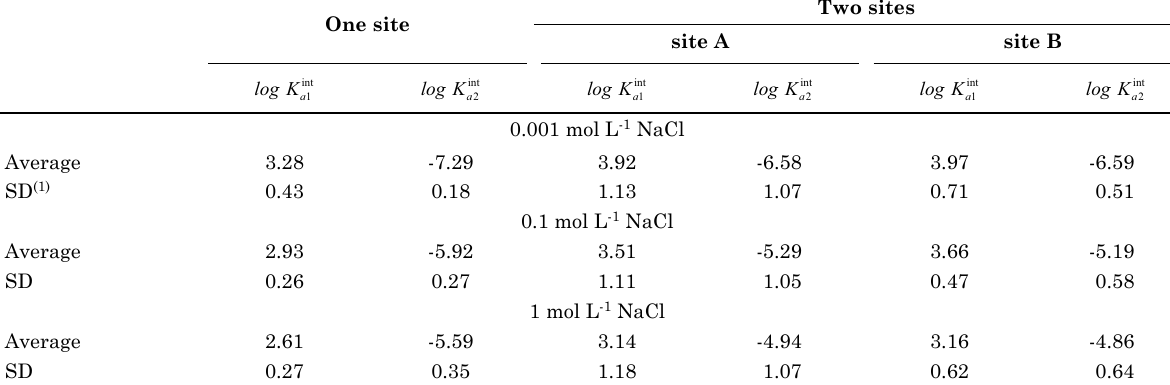
4. average intrinsic equilibrium constants from 17 brazilian oxisols, using the diffuse layer model (dlm), estimated by hand calculation in excel spreadsheets for three ionic